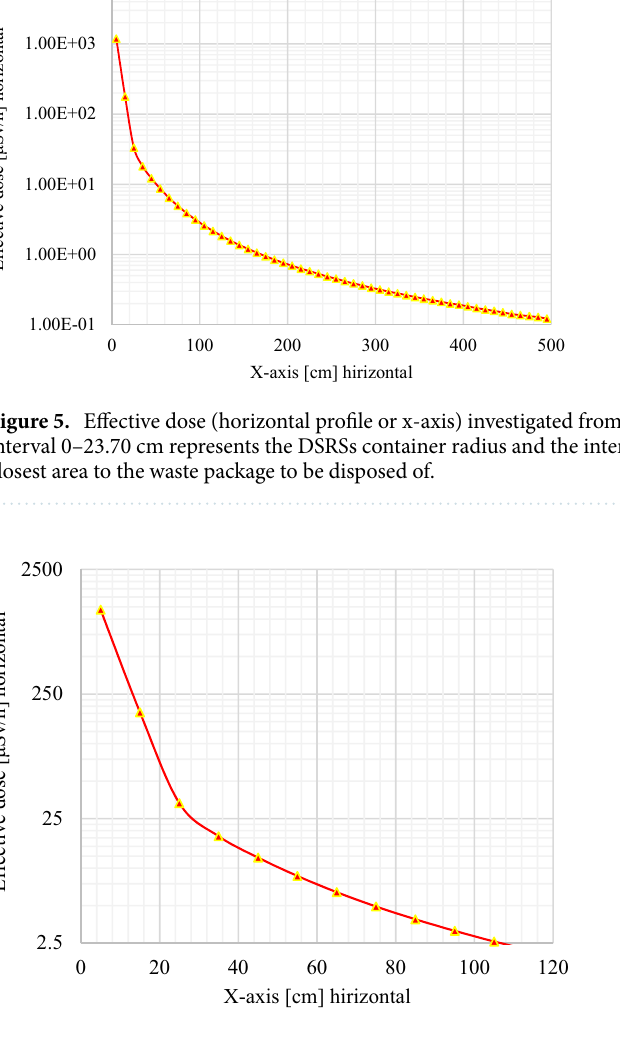
Figure 6. Effective dose profile inside the DSRSs container’s [from 0 to 23.70 cm] and in the closest horizontal boundary area to reach the ALARA acceptable dose limit of 2.5µSv/h for public acceptance. The slope shift observed is mainly due to the change of the medium from the waste package to the enclosure environment (filled with air at ground